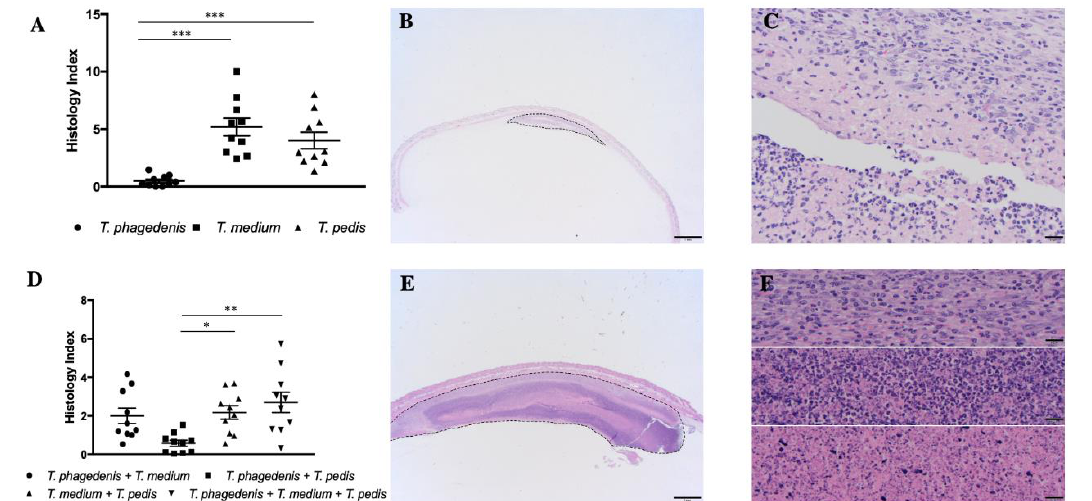
Figure 4. Histopathology of lesions after subcutaneous inoculation with Treponema spp. (haematoxylin and eosin staining). Histology index of single Treponema spp. infection ( A ) and multiple Treponema spp. infection ( D ). T. phagedenis- induced subcutaneous abscess, transverse section (area of the abscess outlined 21,355 pixels 2 ; scale bar = 1 mm) ( B ) and high magnification view (scale bar = 20 µm) ( C ). The upper part presents the relatively narrow fibrovascular capsule composed of proliferating fibroblasts, among which neutrophils are loosely scattered. Deep to this capsule is a layer of macrophages and a dense layer composed predominantly of neutrophils. T. medium -induced subcutaneous abscess, transverse section (area of the abscess outlined 366,519 pixels 2 ; scale bar = 1 mm) ( E ) and high magnification view ( F ). The upper image shows the thick fibrovascular capsule that surrounds the abscess, composed primarily of proliferating fibroblasts among which are scattered neutrophils. The middle panel presents the dense layer of neutrophils and cellular debris at the periphery of the abscess. The lower panel presents the amorphous necrocellular debris at the center of the abscess (scale bar = 20 µm). * p < 0.05, ** p < 0.01, *** p < 0.001.